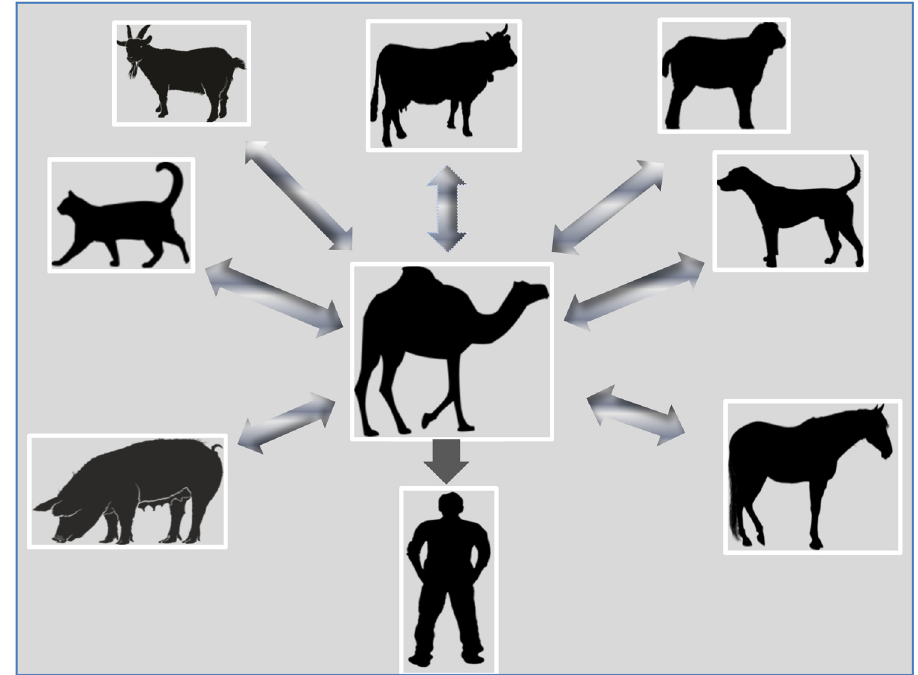
Figure 1: Possible transmission way scheme of B. melitensis and B. abortus from C. dromedarius to susceptible domestic animals and human ( Mammeri )